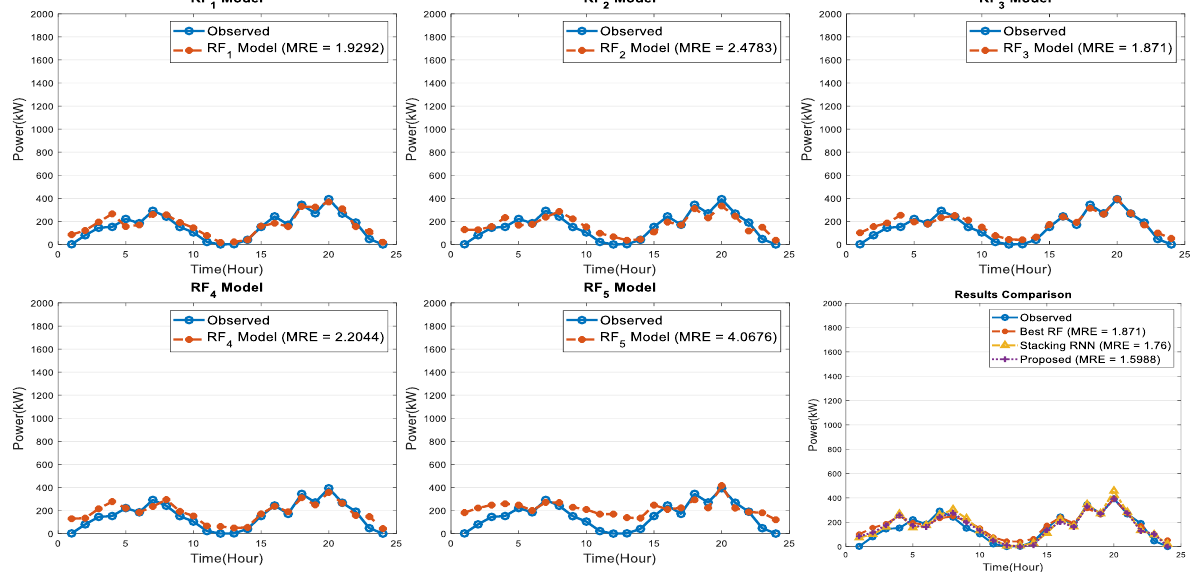
Figure 13. Results for one-day-ahead PV power forecasting for rainy weather conditions. Table 6 compares the proposed method to the RF model and benchmark method in terms of one-day-ahead observations. The proposed method produces the lowest MRE and MAE values. The MRE for sunny weather conditions is 3.492%, and the MRE values for the stacking RNN and the best RF model are 4.495% and 7.905%, respectively. The proposed method gives an MAE of 69.833 kW, and the best RF and stacking RNN models give MAE values of 158.1 kW and 89.893 kW, respectively. The proposed method achieves a 5.222% MRE and a 104.434 kW MAE for light-cloudy weather conditions. The best RF and stacking RNN models give MRE values of 5.833% and 5.607%, respectively, and MAE values of 116.651 kW and 112.13 kW. Table 6. Forecasting accuracy for all weather conditions. Error Validation